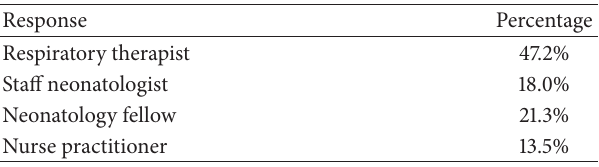
Table 3: Ideal position on